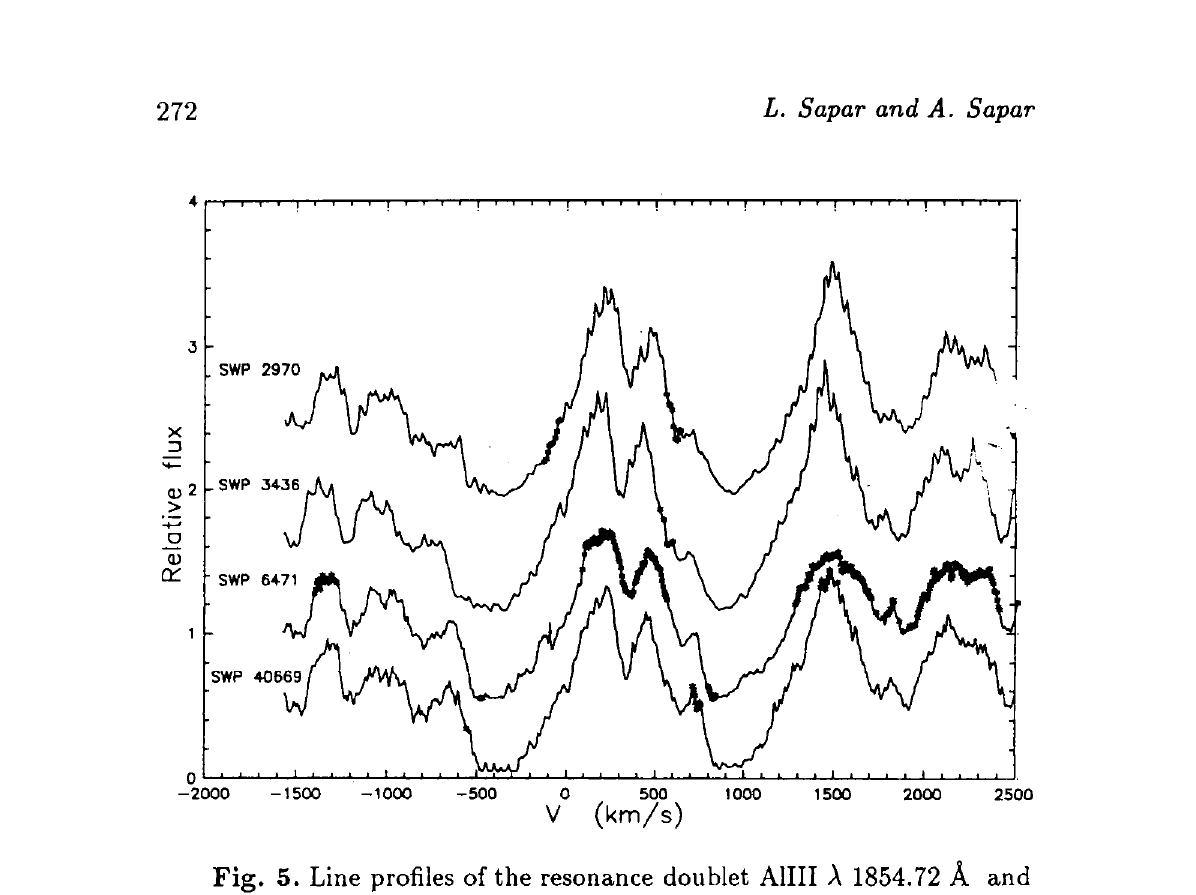
Fig. 5. Line profiles of the resonance doublet A1III A 1854.72 A and A 1862.79 A. The space between doublet components is 1300 km/s. Mod- erate variations are seen both in the profiles of resonance line components and in the nearby subordinate lines. The variations show that O" has a moderate variability of about 100 km/s in the extreme mass outflow velocity and a considerable variability in the strong subordinate lines. Im- pressive are changes of the Nilll A 1847.2 A line and of the Nilll A 1849.5 A and Fell A 1849.7 A blend at the blue edge of the A1III A 1854.72 A line. The red peak of this spectral line has been splitted into two by the